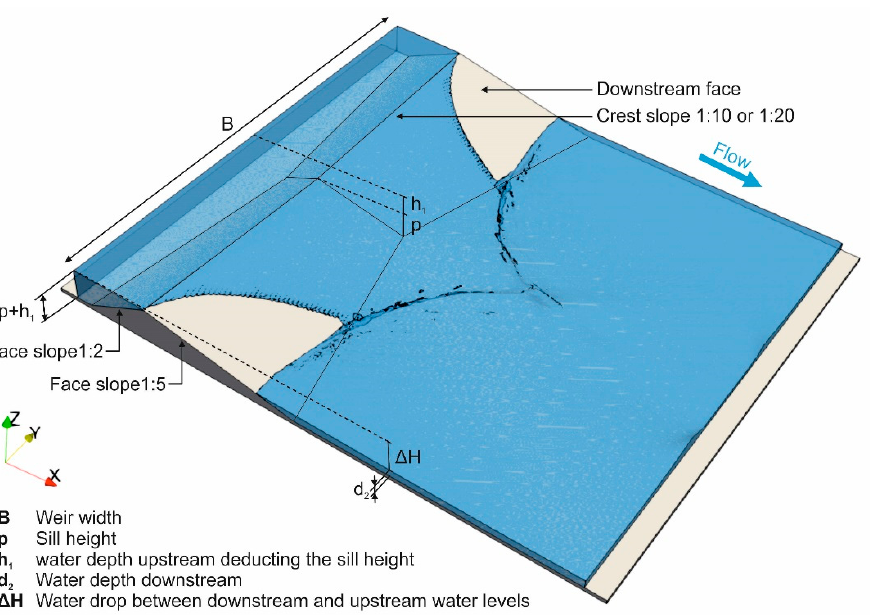
Figure 1. Flat-V weir and its main geometrical parameters. Check ISO Standard 4377:2012 for a broader geometrical description.